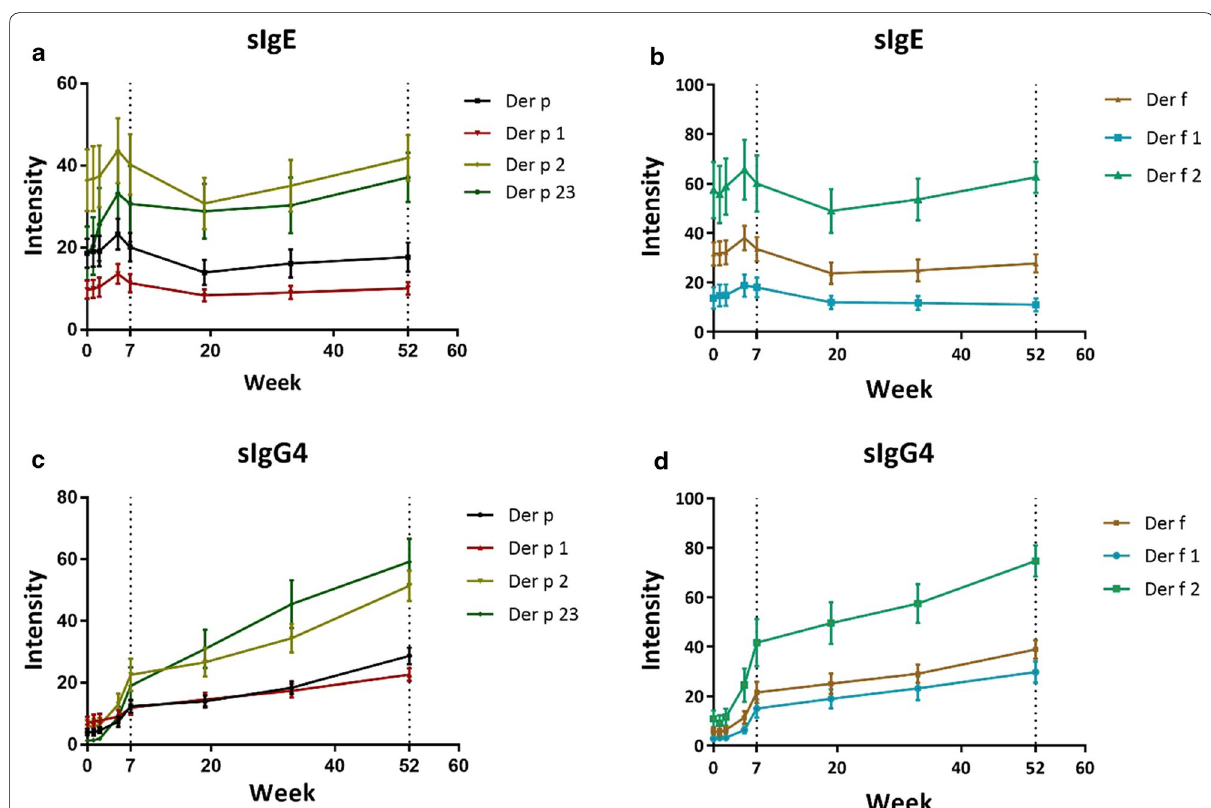
Fig. 1 The profiles of sIgE and sIgG4 levels generated for allergenic HDM components during AIT. a sIgE of Der p and its components; b sIgE of Der f and its components; c sIgG4 of Der p and its components; d sIgG4 of Der f and its components. HDM, house dust mite; AIT, allergen